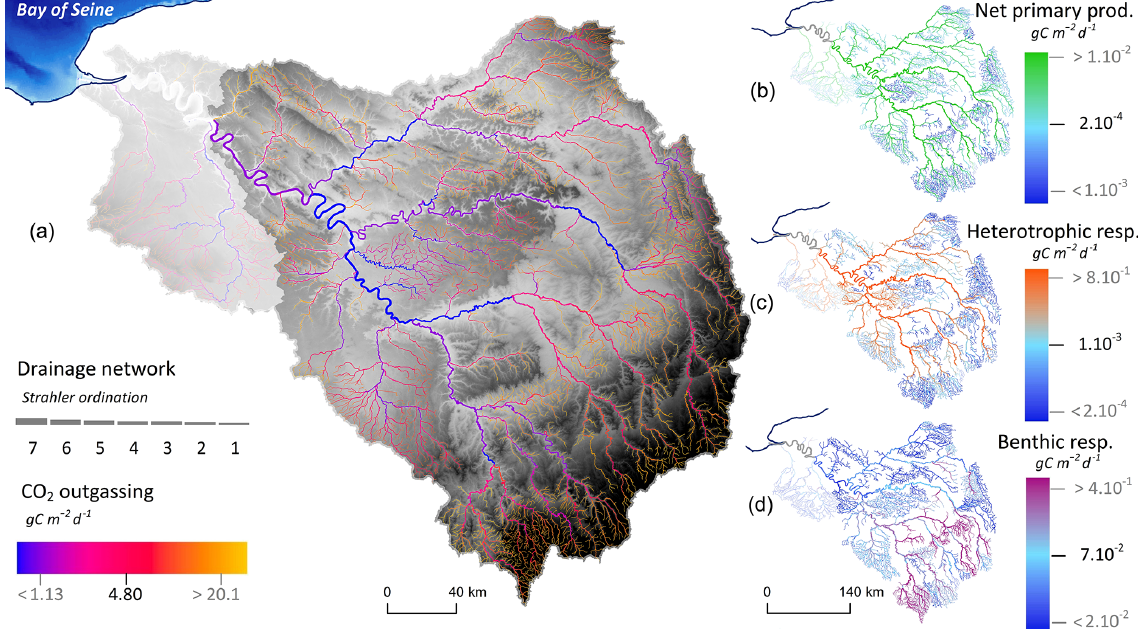
Figure 8. Instream processes involved in the inorganic carbon cycle simulated by pyNuts-Riverstrahler and averaged over the 2010–2013 pe- riod for the Seine River network until its fluvial outlet at Poses. (a) CO 2 outgassing (blue–yellow, gCm − 2 d − 1 ), (b) net primary production (blue–green, gCm − 2 d − 1 ), (c) heterotrophic planktonic (blue–violet), and (d) benthic respiration (blue–orange, gCm − 2 d − 1 ) are repre- sented in the hydrographic network.